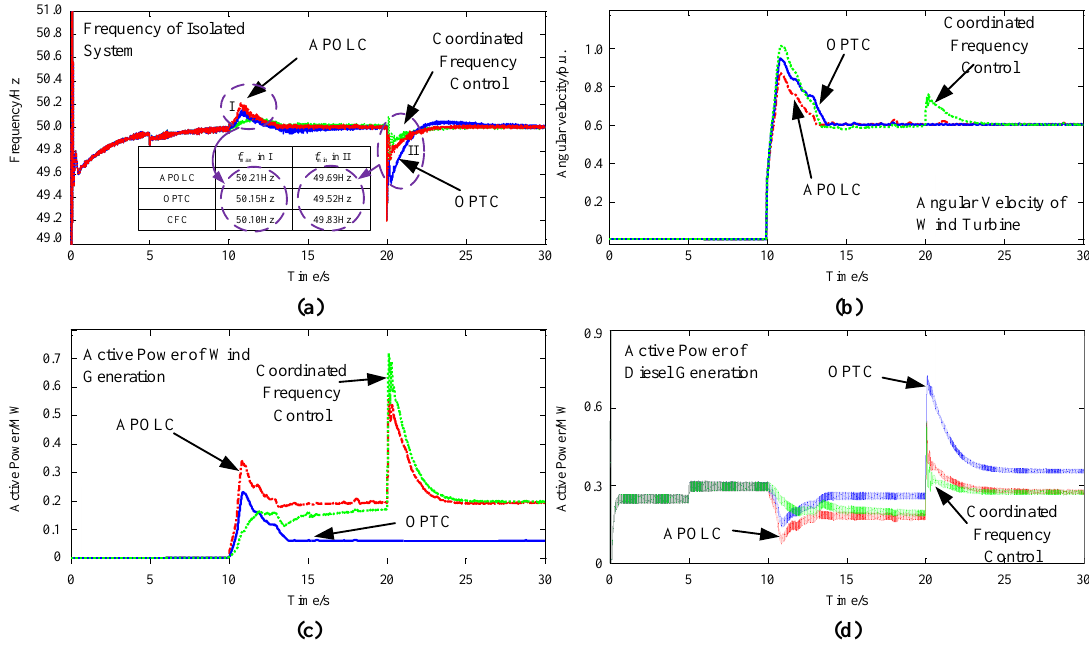
Figure 11. Simulation results of the entire control procedure of the proposed strategy: ( a ) frequency of the isolated system; ( b ) angular velocity of the wind turbine; ( c ) active power of wind generation; and ( d ) active power of diesel generation.